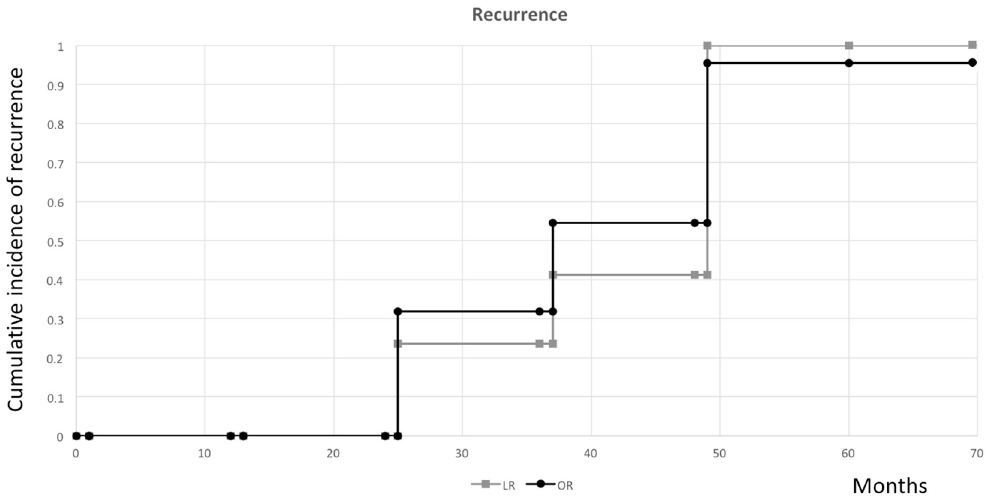
Figure 3. Cumulative incidence curve of tumor recurrence in all stage patients ( p = 0.186).